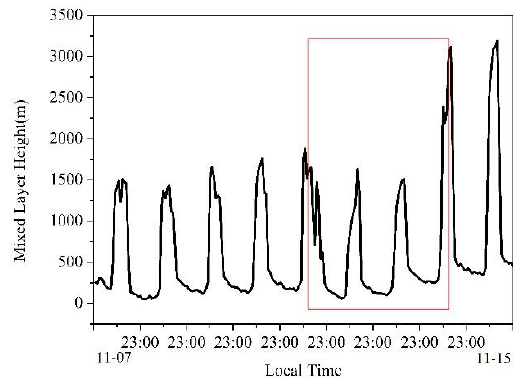
Figure 3. Mixed layer height observed at Tazhong in the TD (Red box is dusty weather period).